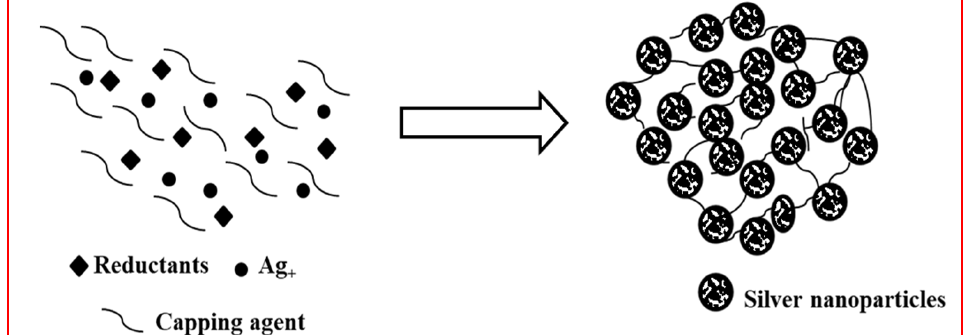
Figure 2. Chemical synthesis of silver